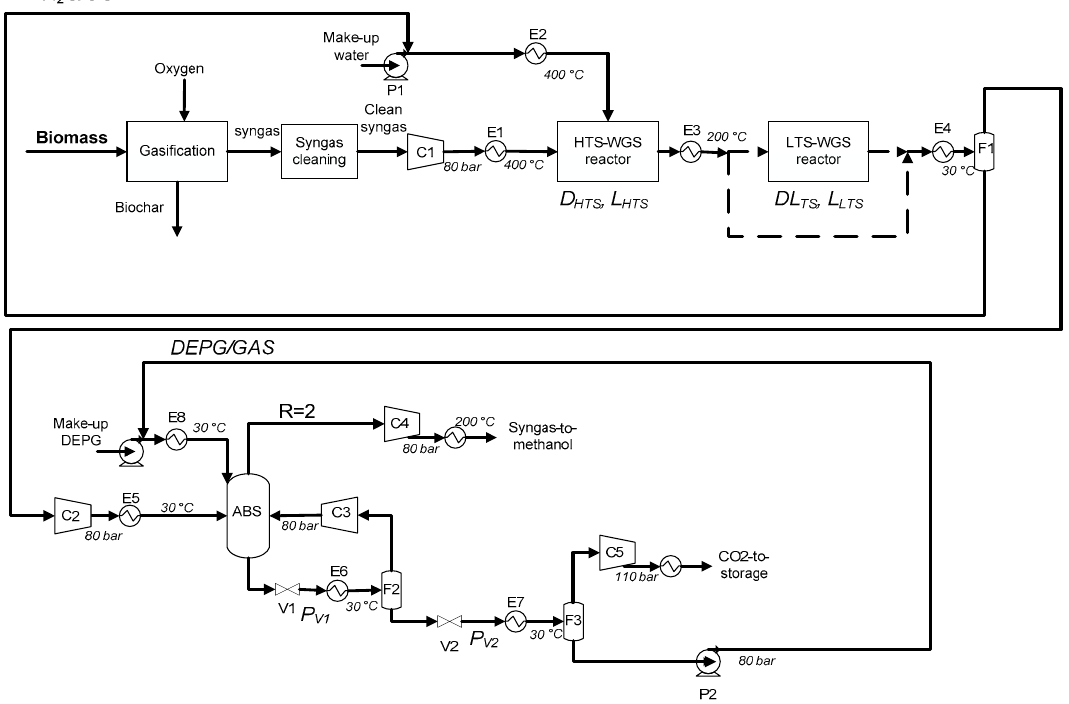
Figure 2. The syngas-to-methanol production flowsheet considered in this work.